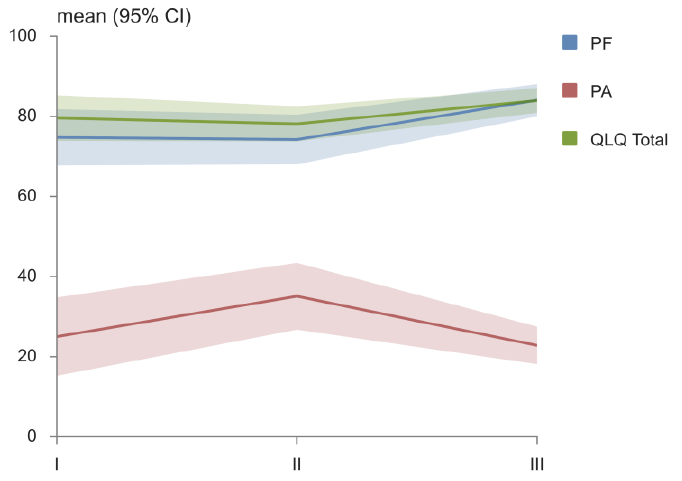
Figure 3. EORTC QLQ–C30—European Organization for Research and Treatment of Figure 3. EORTC QLQ – C30 — European Organization for Research and Treatment of Cancer – Qual-